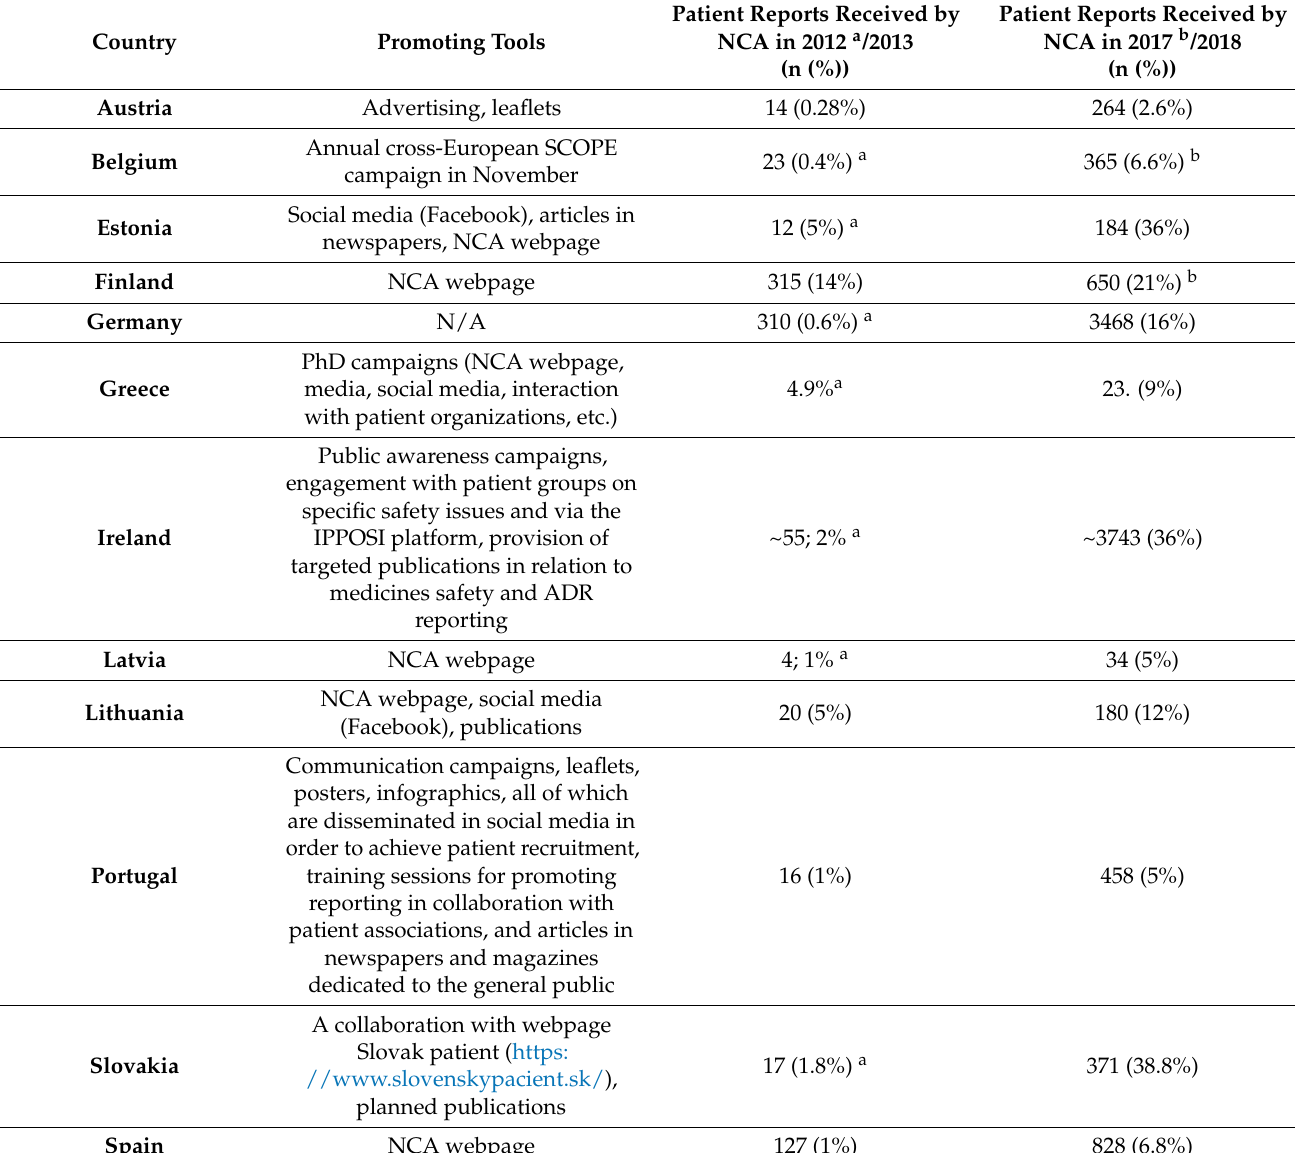
Table 2. Adverse drug reaction (ADR) reports submitted by patients in the participating